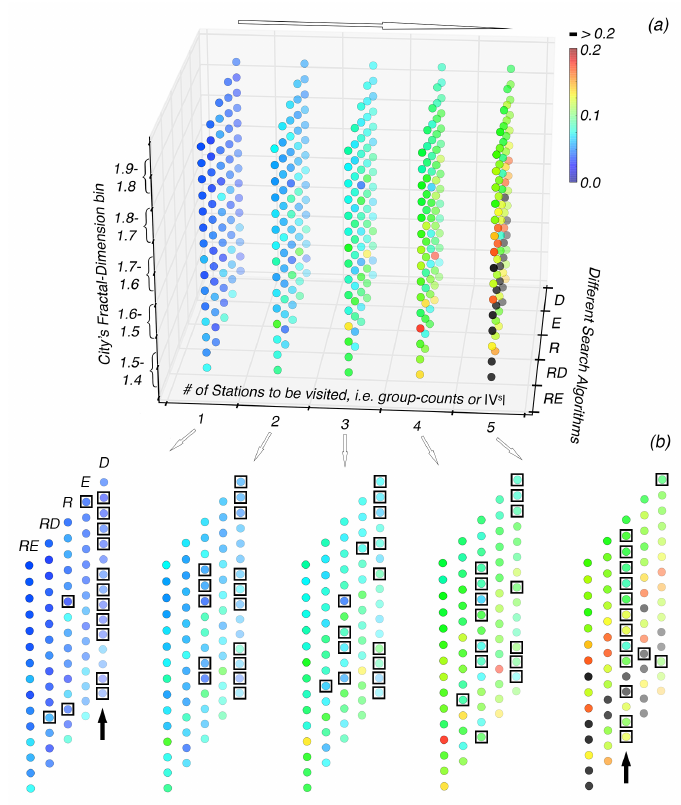
Figure 4. 3D-graph between Different Search Algorithms, Number of Stations to be visited, i.e., | V s | , and City’s Fractal-Dimension bin. Each bin represents three cities taken from Figure 3. Color represents the average fractional error in route-length coming out from each algorithm with respect to the optimal one (estimated by brute-force), with the color black having errors of more than 20%. ( a ) It should be noted that, with an increase in the | V s | for a given E-GTSP instance, the error also gets increased irrespective of the choice of the algorithm (marked by big arrow). ( b ) The graph is sliced-down for each group-count, individually. For each city, the algorithm with the least errors is marked by black box. It is clear that, for small | V s | values, the D-Search is better, and, as one increases the number of stations, the R-Search outperforms the other, marked by solid-arrows. Overall, the R-Search is advised for any urban based E-GTSP to TSP conversion (Section